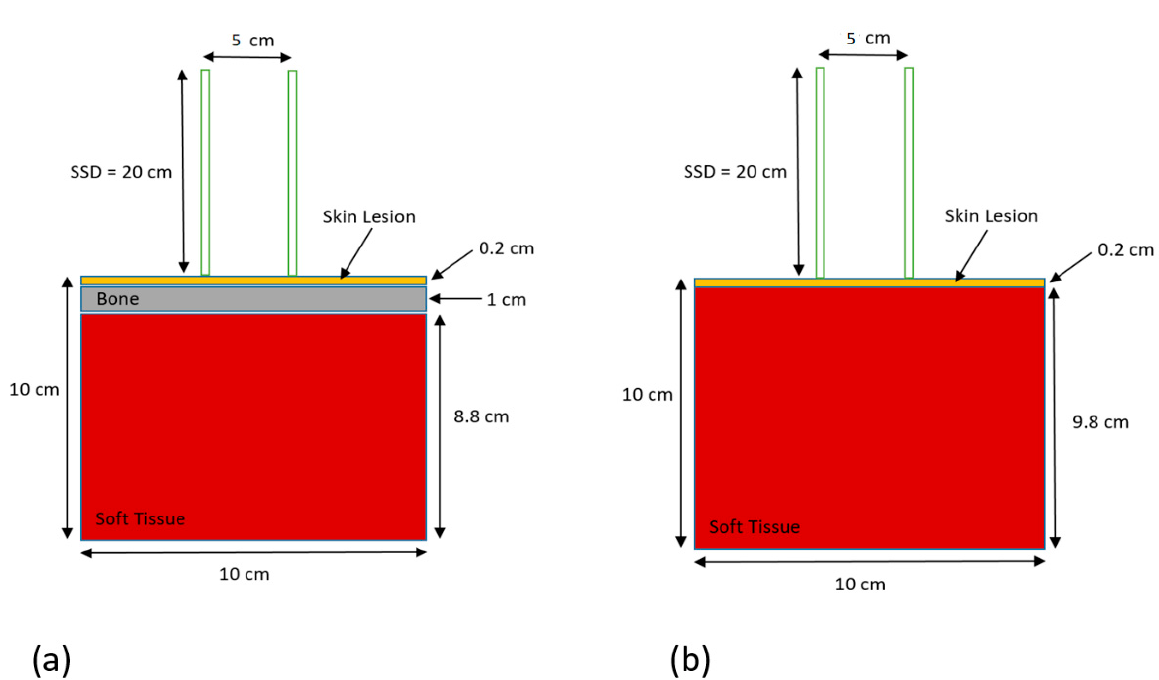
Figure 1. Schematic diagrams (not to scale) showing the heterogeneous phantoms used in Monte Carlo simulations, ( a ) with and ( b ) without a bone between the skin lesion and the soft tissue. The dimensions of the phantoms were equal to 10 × 10 × 10 cm 3 . The phantoms were irradiated by the 105 and 220 kVp photon beams with circular cone applicator (5 cm diameter) attached to the phantom’s surface. The source-to-surface distance (SSD) was equal to 20 cm, mimicking the clinical dose delivery.